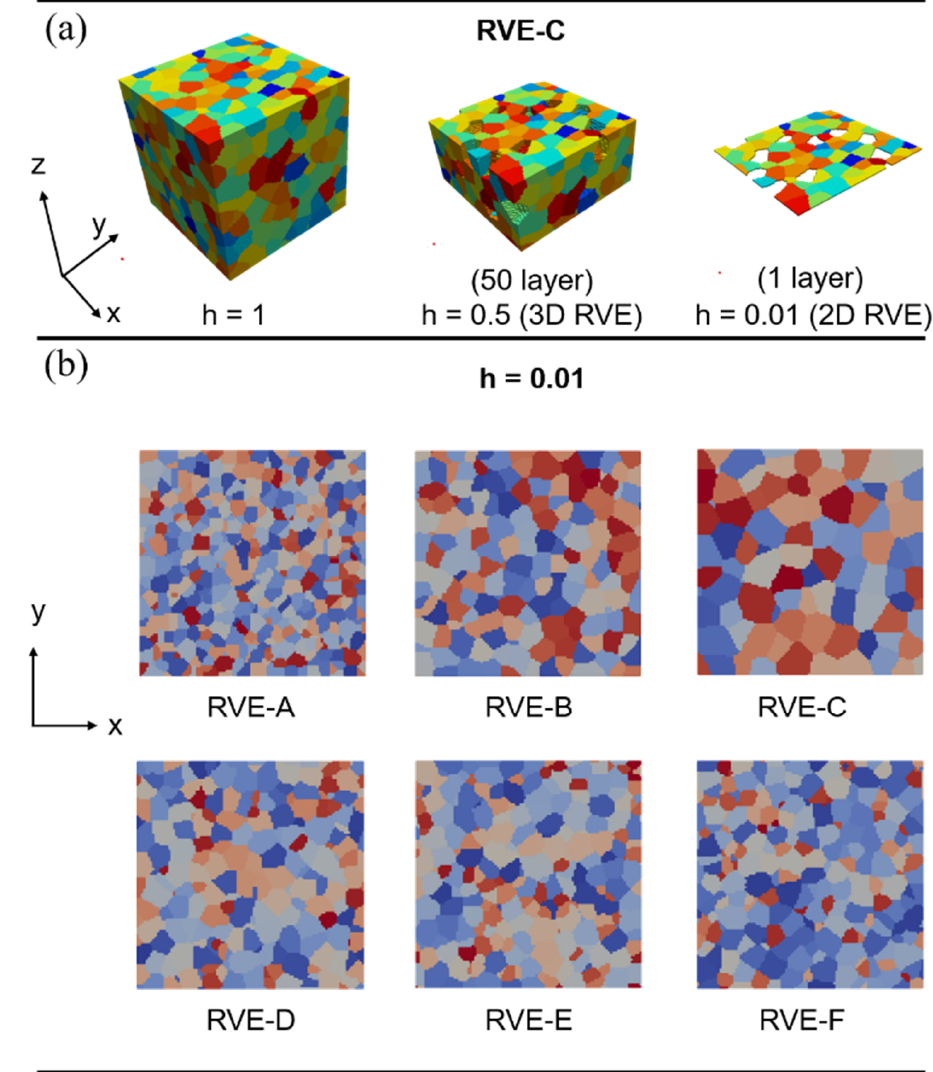
Figure 2. ( a ) The resulting RVE-C initial microstructure colored according to the inverse pole figure (IPF). ( b ) All RVE models (RVE-A to RVE-F) were sliced into geometries with 1-layer (h = 0.01) RVE in terms of texture style.